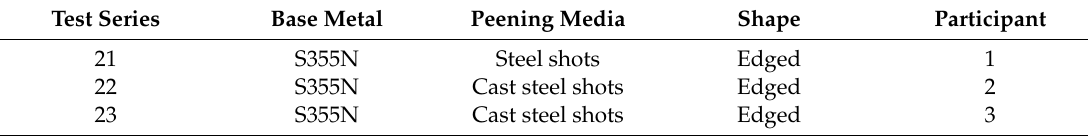
Table 5. Additional test series of industrially clean blasted specimen (round robin